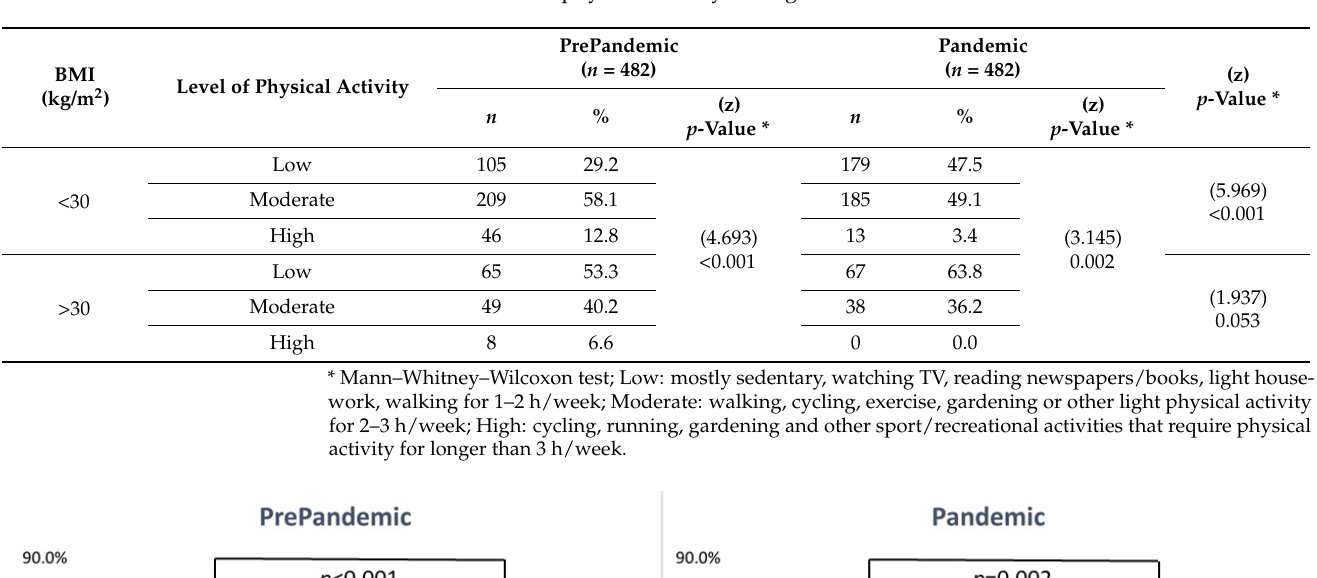
Table 5. Assessment of physical activity during leisure time.